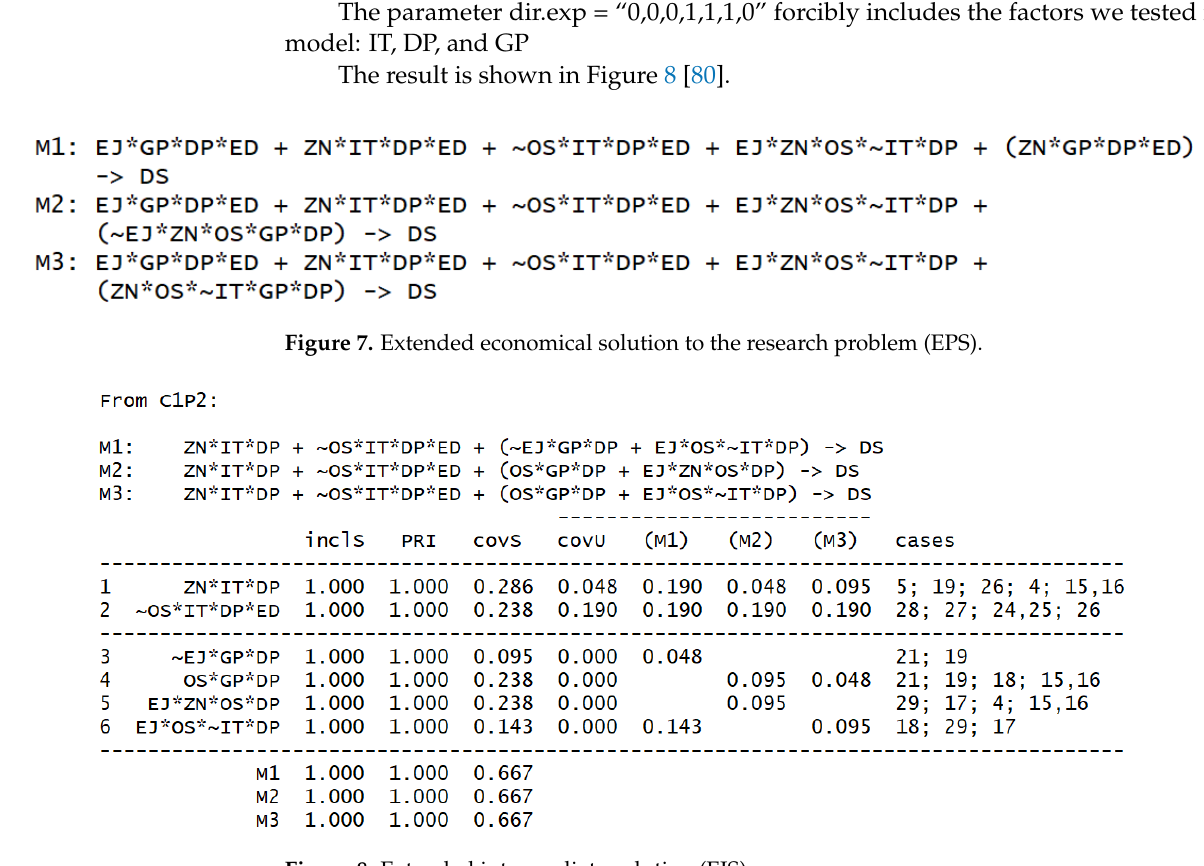
Figure 8. Extended intermediate solution (EIS).